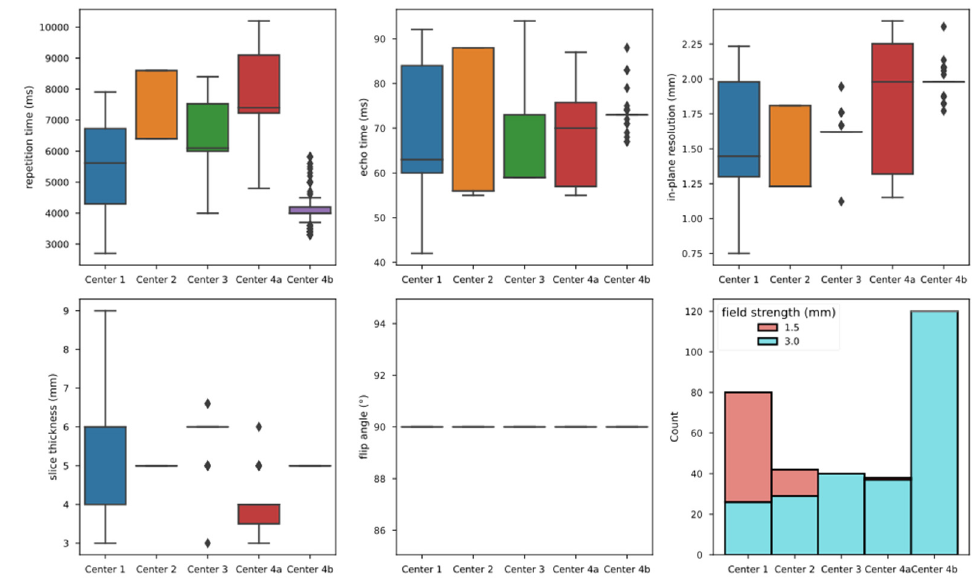
Figure 2. Distribution of selected imaging parameters per center for the T2w images.